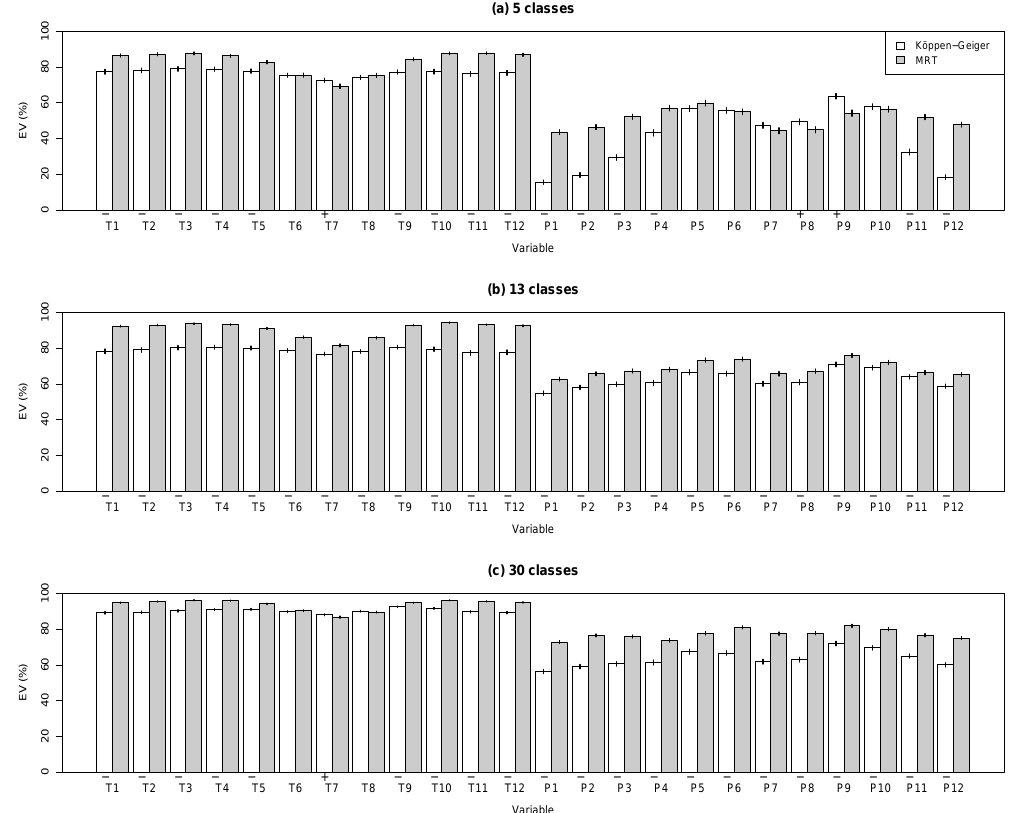
Fig. 7. EV (monthly temperature, T1 to T12, and precipitation, P1 to P12) of the K¨oppen-Geiger and MRT climate classifications at the (a) 5, (b) 13, and (c) 30 class levels. Error bars indicate 95% confidence interval (CIs); ± signs along the horizontal axis indicate variables for which the 95% CI for the K¨oppen-Geiger classification lies outside (above/below) the CI for the MRT classification.